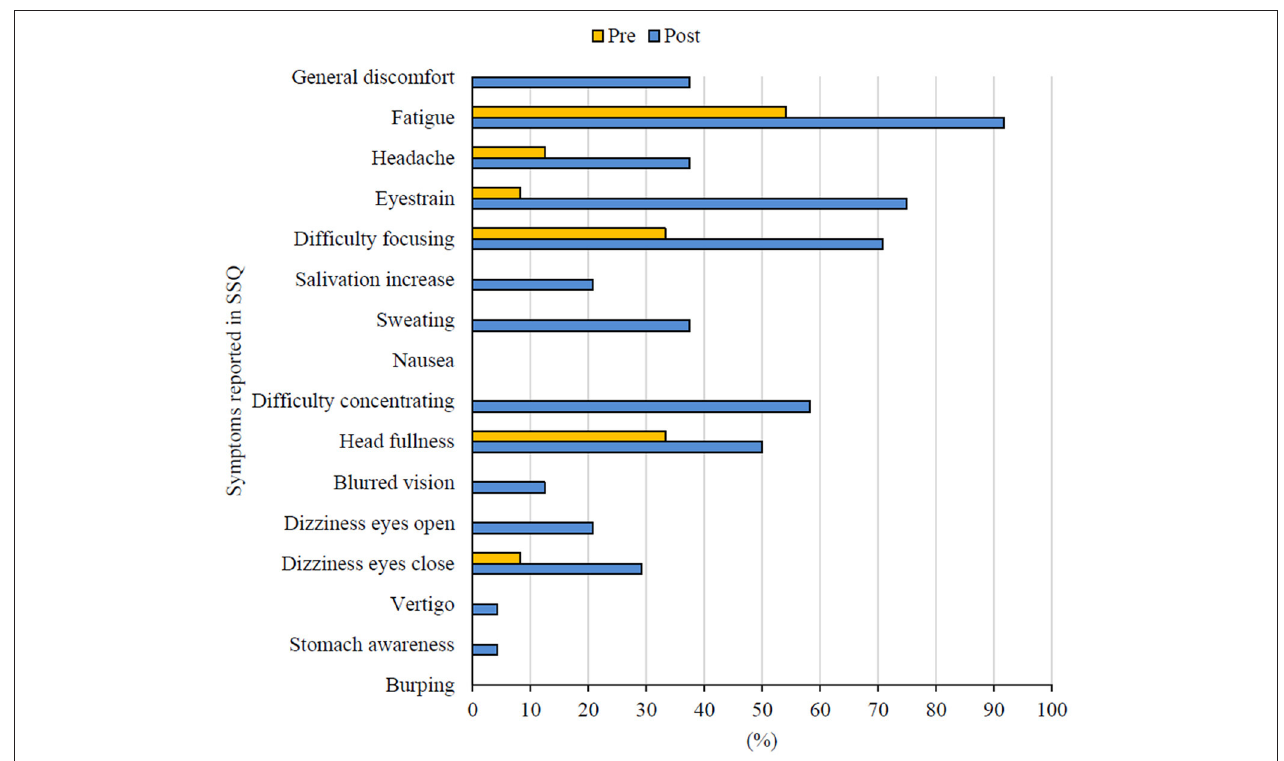
FIGURE 4 | The frequency of symptoms reported in pre- and post-exposure SSQs.